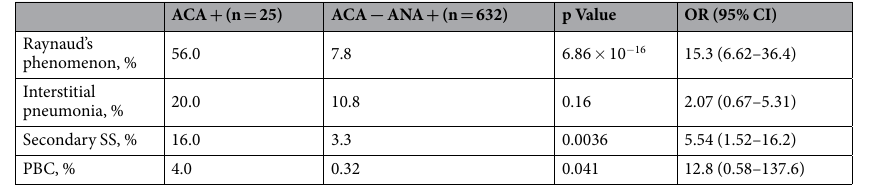
Table 4. Clinical manifestations and complications in ACA-positive RA patients among ANA-positive RA subjects. ACA, anti-centromere antibody;OR, odds ratio; 95% CI, 95% confidence interval; SS, Sjögren’s syndrome; PBC: Primary biliary